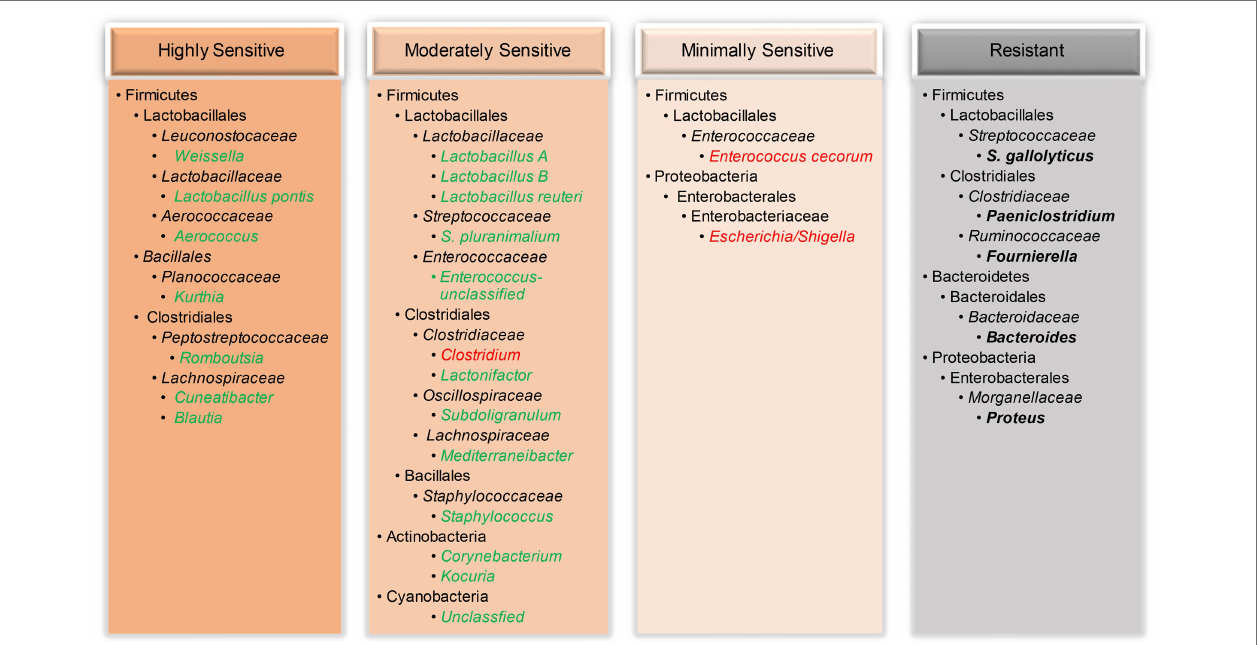
FIGURE 8 | Classification of the ileal bacteria and their taxonomies based on their sensitivity to NE. While a majority of bacteria were abruptly vanished (highly sensitive) or gradually diminished (moderately sensitive) by NE, a few bacteria were only enriched during severe disease (minimally sensitive) or remained unchanged (resistant) by NE. Reduced bacterial taxa were indicated in green, and enriched bacteria were highlighted in red, while unaltered bacteria were indicated in bold